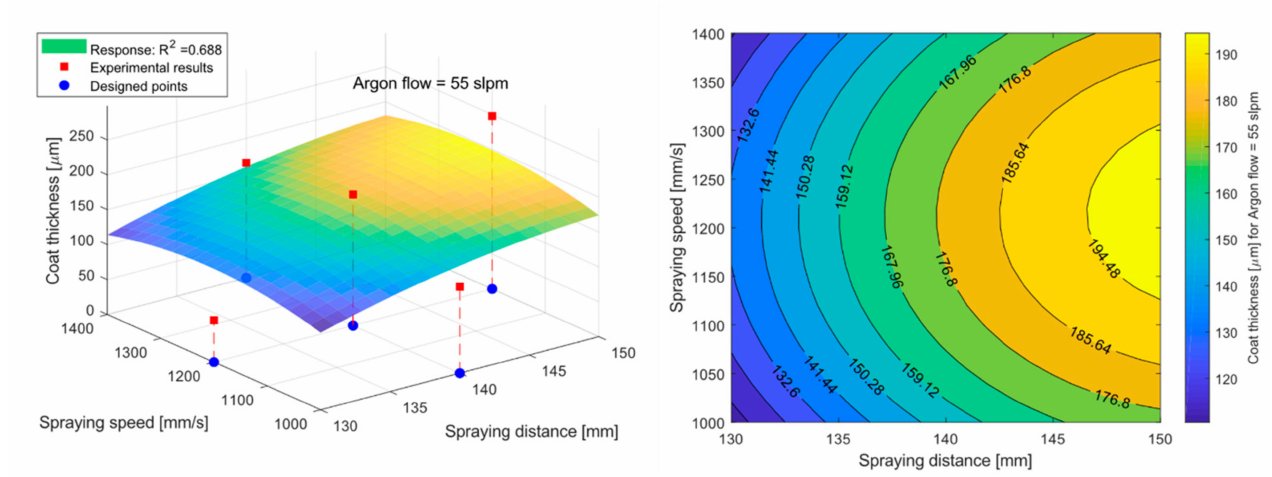
Figure 6. Response surface of the obtained coating thickness for a fixed argon flow of 55 slpm.